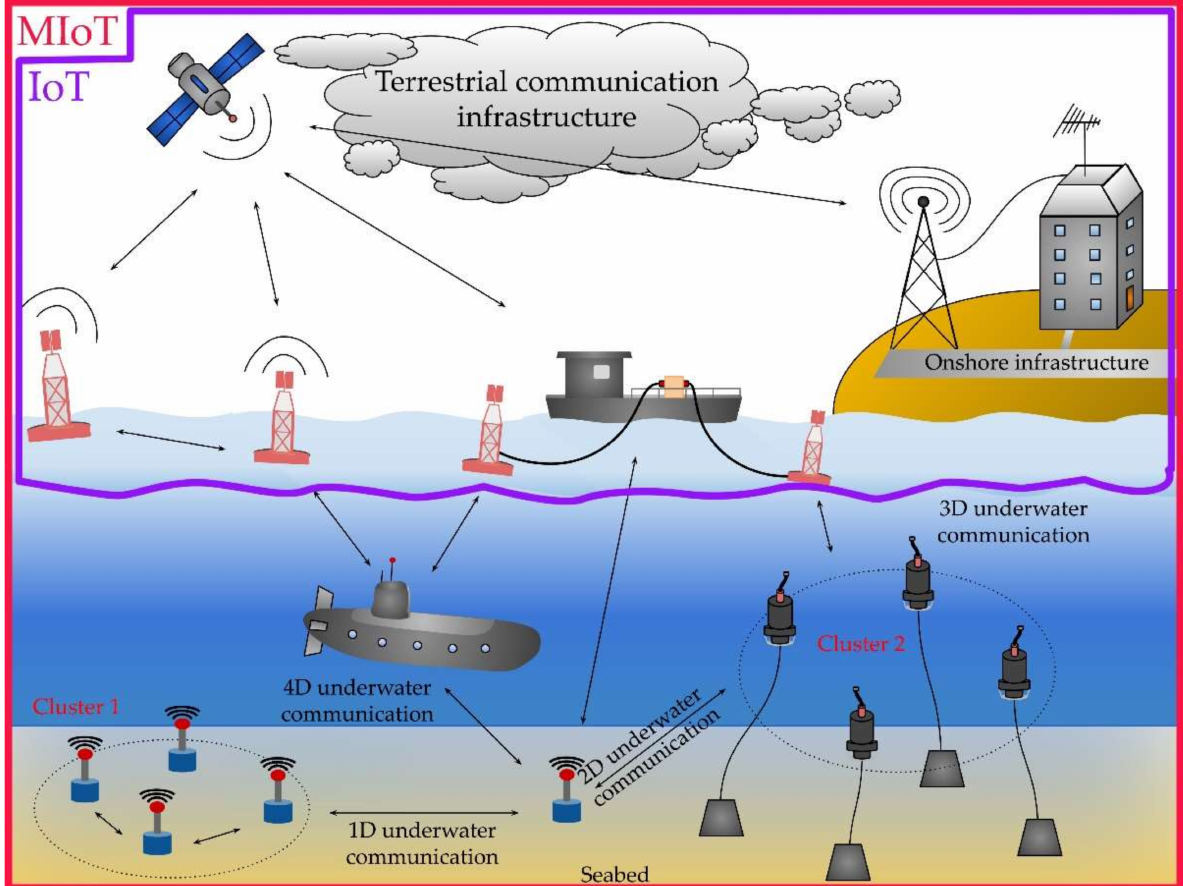
Figure 1. Architecture based on 1D–4D